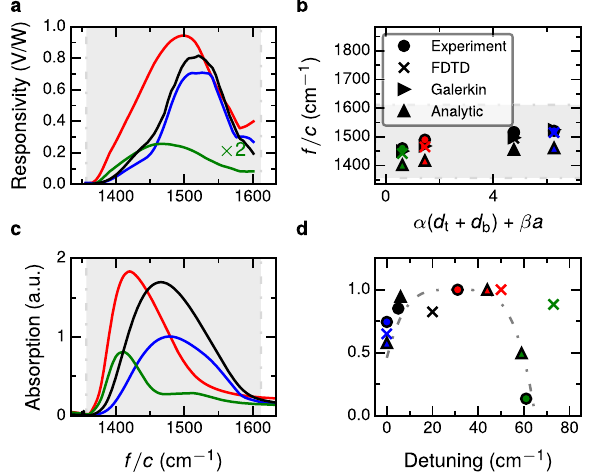
Fig. 4 Comparison between experiments, simulation and analytic model. a Responsivity spectra of the investigated devices. b Comparison of the peak frequency of the devices obtained experimentally, by FDTD simulation, by the Galerkin method (Supplementary Information) and using the analytic model. Where d t and d b are the top and bottom thicknesses of the h-BN respectively and a is the gap width. The parameters α and β are extracted from the analytic model (Supplementary Information). c Absorption spectra calculated analytically. d Normalized peak values as a function of the detuning (see text) of its frequency. The gray dashed dotted line is a guide to the system. These are the stack thickness d = d t + d b , where d t and d b are the bottom and top h-BN thicknesses (Fig. 1c), and the split gate gap width 2 a . The tunability of the investigated devices spans over 60 cm − 1 and the peak frequencies obtained using both